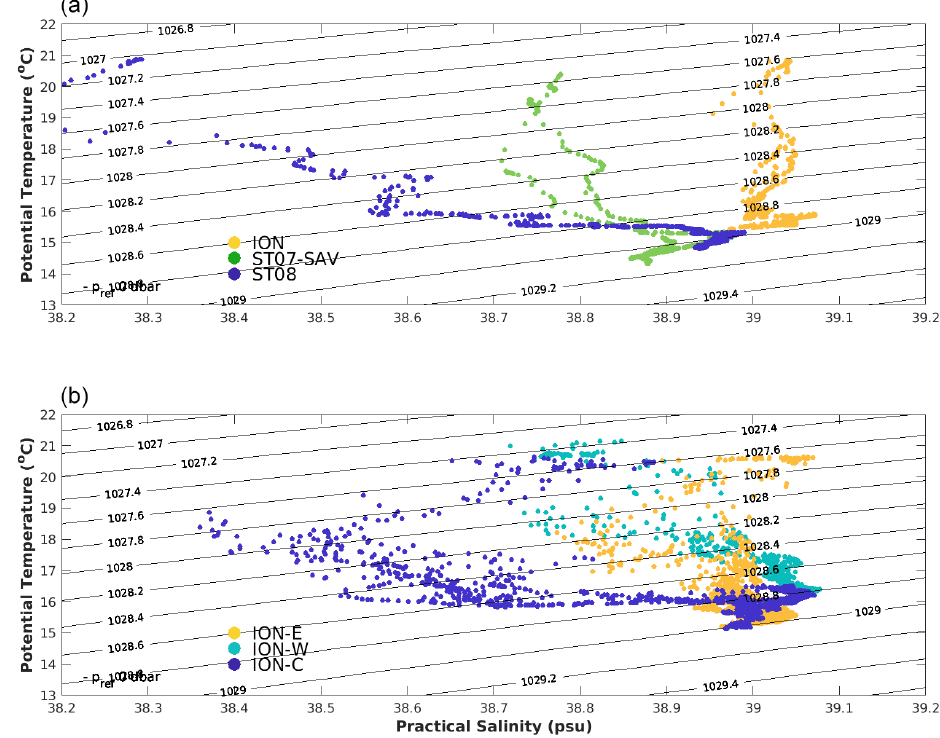
Figure 6. T – S diagram for stations ION, SAV, ST7 and ST8 restricted to 0–300m (a) and for ION-Tr parts (b) ION-W, ION-C and ION-E. Table 2. LOPC particle-derived parameters for ION-Tr, ST8 and SAV, for three depth layers. Abund is total abundance, and BioV is total